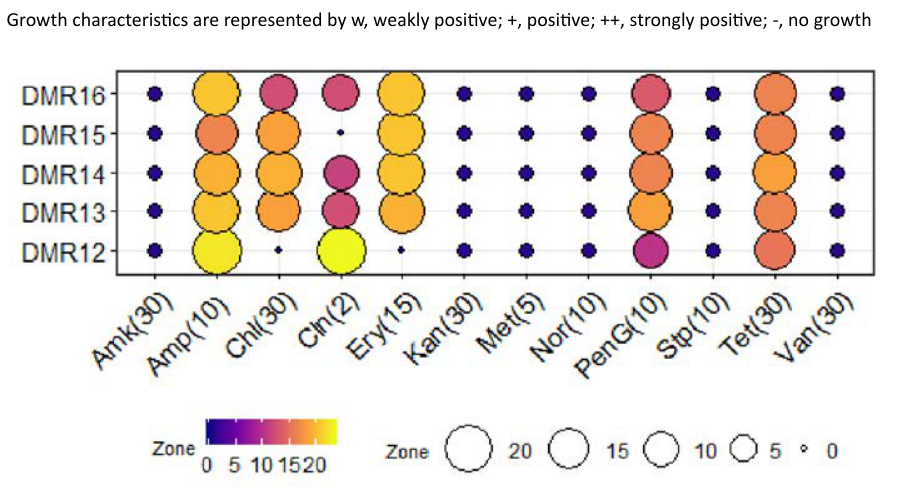
Fig. 6. Antibiotic sensitivity of LAB isolates. Blue dark, purple colour circles indicates the resistant characteristics while Yellow and dark colour circles represent the sensitive characteristics. Conc. of the antibiotics is indicated in parenthesis in the unit of mcg.